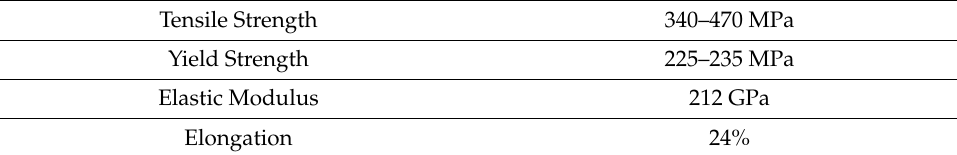
Table 2. Basic mechanical properties of S235J0 steel at 20 ◦ C